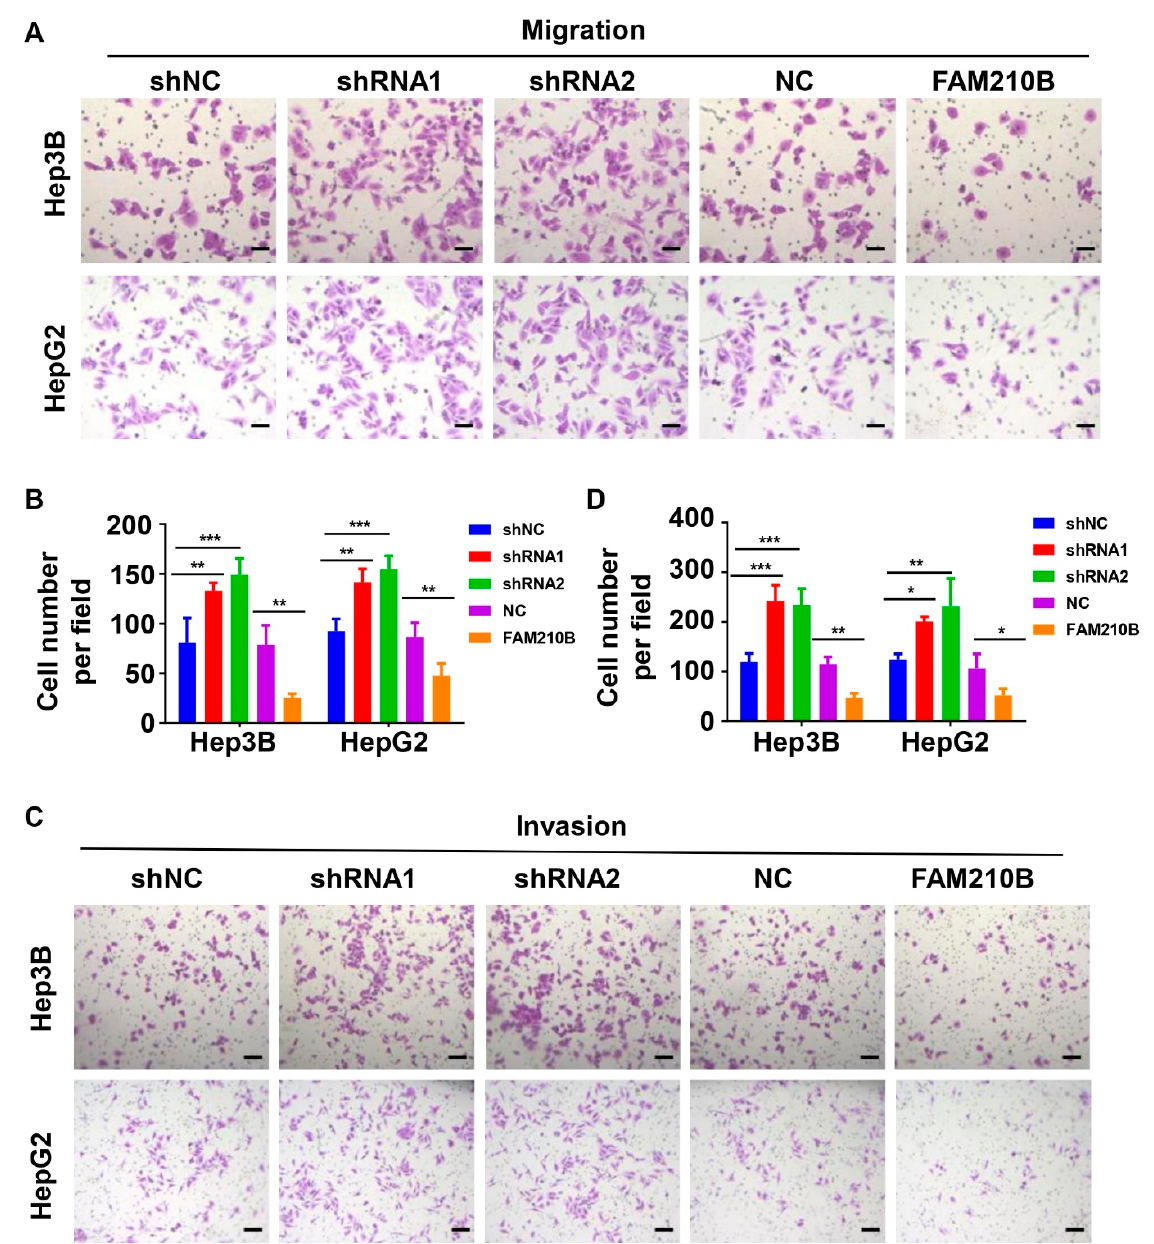
Figure 5. Loss of FAM210B promotes HCC cell metastasis in vitro. ( A ) The transwell migration assay was conducted in Hep3B and HepG2 cells following transfection with FAM210B shRNA lentivirus or FAM210B overexpression lentivirus. (Scale bar = 200 µ m). ( B ) Statistical graphs of cell transmembrane numbers of the two groups. ( C ) Stable downregulation of FAM210B expression increased the invasive potential of Hep3B and HepG2 cells in vitro as per Matrigel chamber experiments, but upregulation of FAM210B decreased invasiveness. (Scale bar = 400 µ m). ( D ) Statistical graphs of cell transmembrane number in the two groups. *: p < 0.05; **, p < 0.01; ***, p <